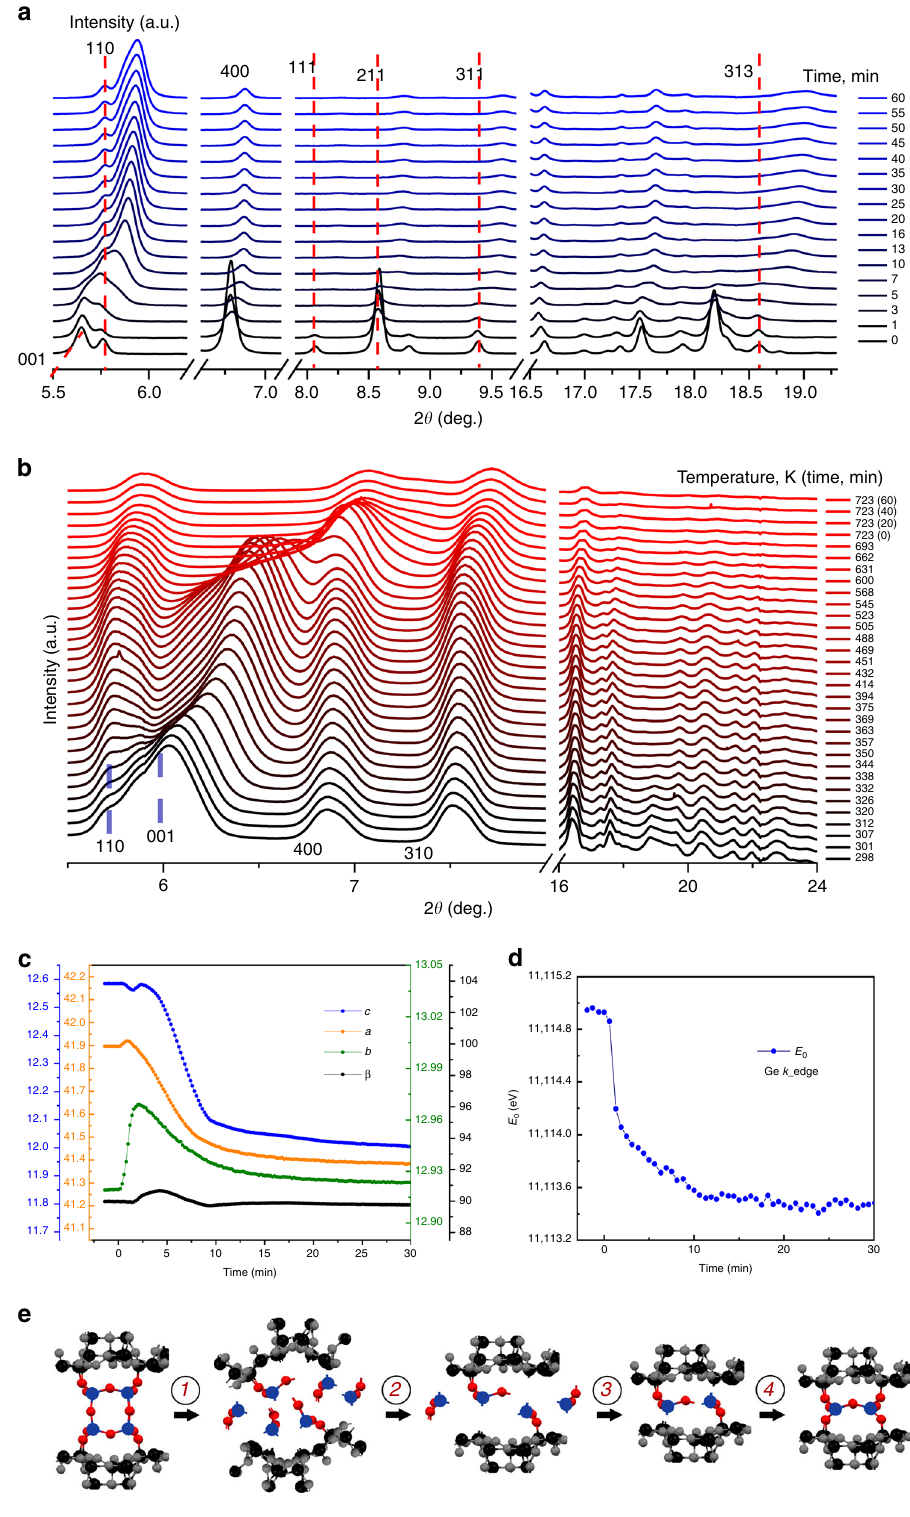
(3) slow rearrangement of the species remaining in the interlayer space until reaching the equilibrium state at RT (>10 – 12 min) (4) layers condensation (reassembly) at slightly increased temperatures (up to 350 K) with no effect on the structure of the